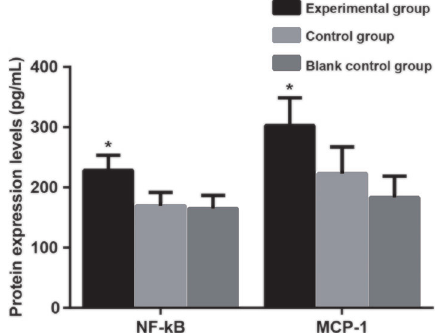
Figure 3. Serum monocyte chemotactic protein 1 (MCP-1) and nuclear factor kappa B (NF- k B) levels among the spinal tuberculosis (experimental), sham-operated (control) and blank groups detected by ELISA. *P o 0.05 compared with the blank and sham groups (ANOVA).